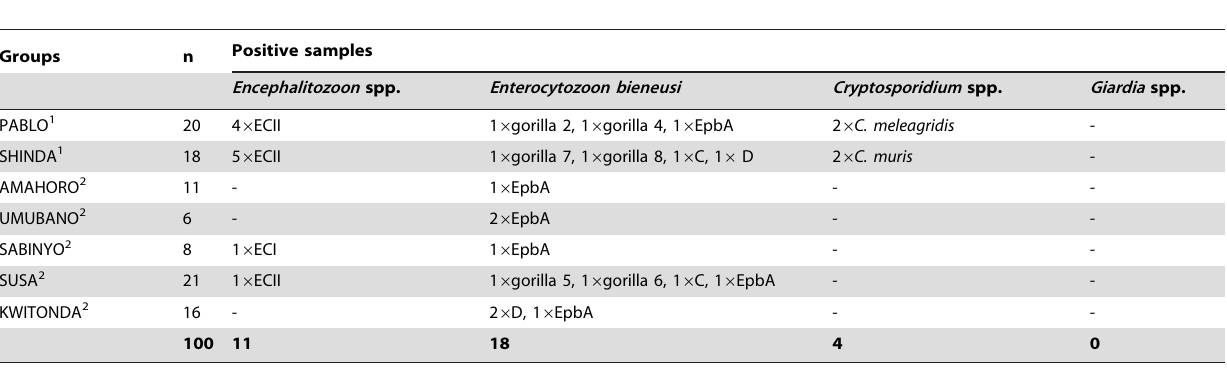
Table 1. Enterocytozoon bieneusi, Encephalitozoon cuniculi, Cryptosporidium spp. and Giardia spp. infection in mountain gorillas ( Gorilla beringei beringei